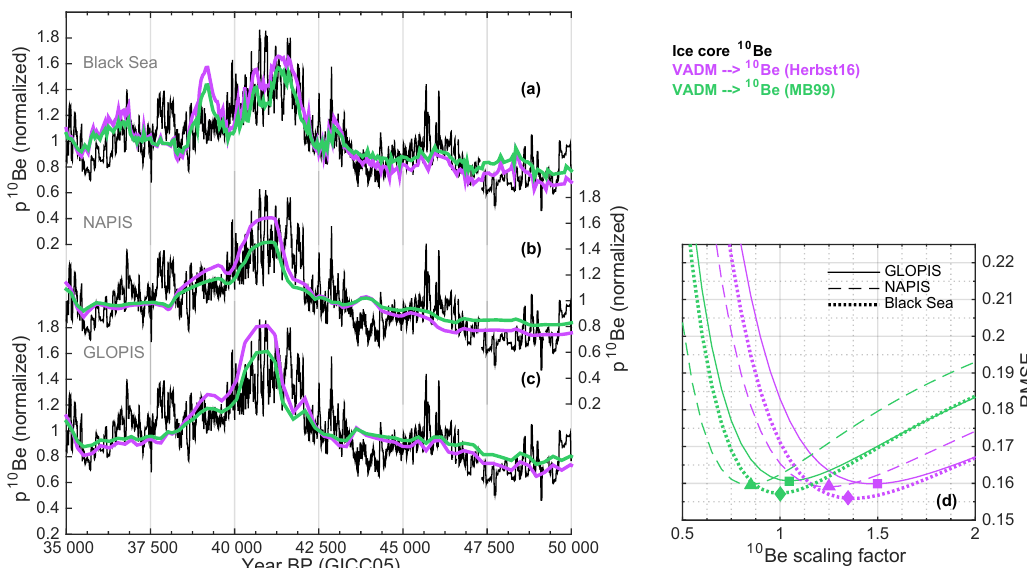
Figure 3. Comparison of ice-core-based and geomagnetic-field-based reconstructions of 10 Be production rates. (a–c) The ice-core stack (black) in comparison to 10 Be production rates based on geomagnetic field reconstructions and two different production rate models (Herbst et al., 2016, in pink and Masarik and Beer, 1999, in green). (a) The Black Sea geomagnetic field record (Nowaczyk et al., 2013), (b) the NAPIS geomagnetic field stack (Laj et al., 2000), and (c) the GLOPIS geomagnetic field stack (Laj et al., 2004). (d) The RMSE between the ice-core data and the geomagnetic-field-based records when variations in the ice-core record are scaled by different factors ( x axis). The colors correspond to the production rate models. The line styles indicate the geomagnetic field records (see legend) and the symbols denote the RMSE